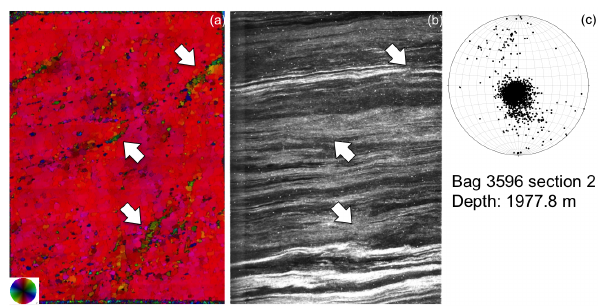
Figure 6. Comparison of fabric data and visual stratigraphy in de- tail, bag 3596, approximate depth 1977.8m. (a) Fabric data in a ver- tical section, (b) line scan image, in a vertical section, and (c) stereo plot of c axes orientations (horizontal plane).